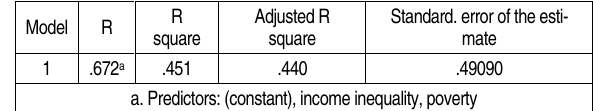
Table 8. Correlation between income inequality and